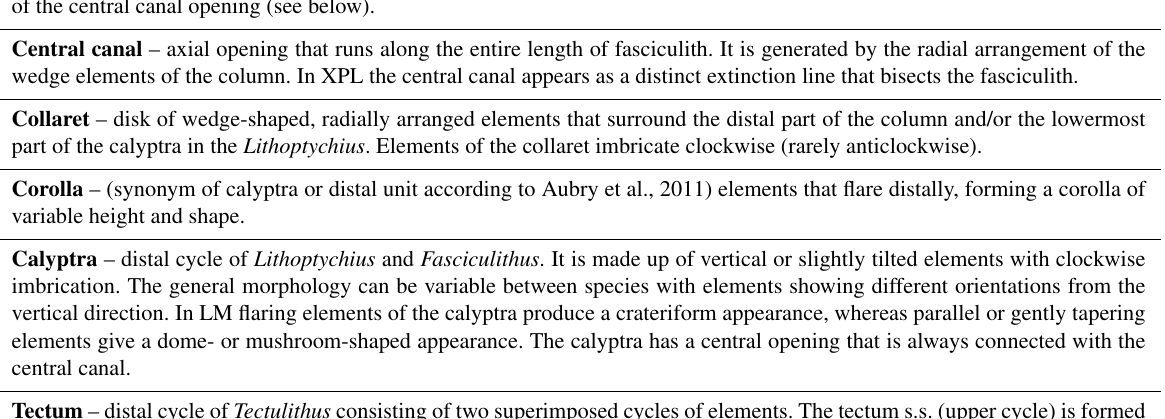
Table 1. Terminology used in the taxonomic